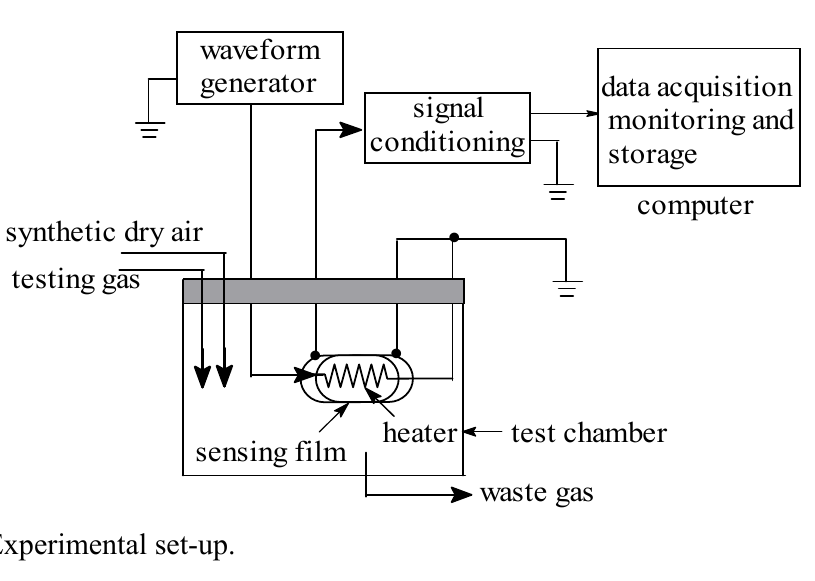
Figure 1. Experimental set-up.